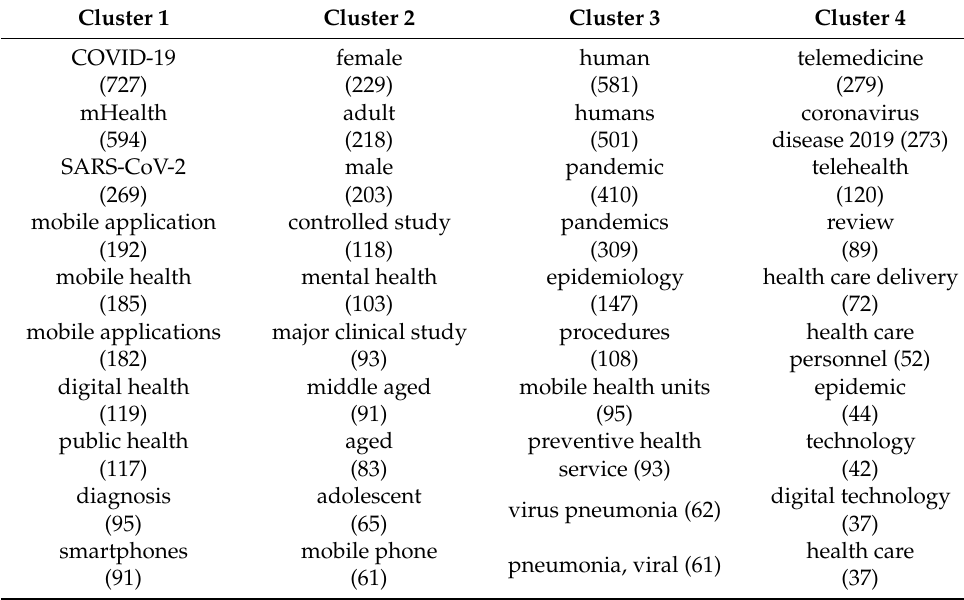
Figure 4. Co-occurrence of keywords analysis. (Note: Four clusters were identified with the largest one (red in color) with 33 keywords; see the text for more details). Table 7. Top 10 keywords in each cluster with frequency of occurrences.